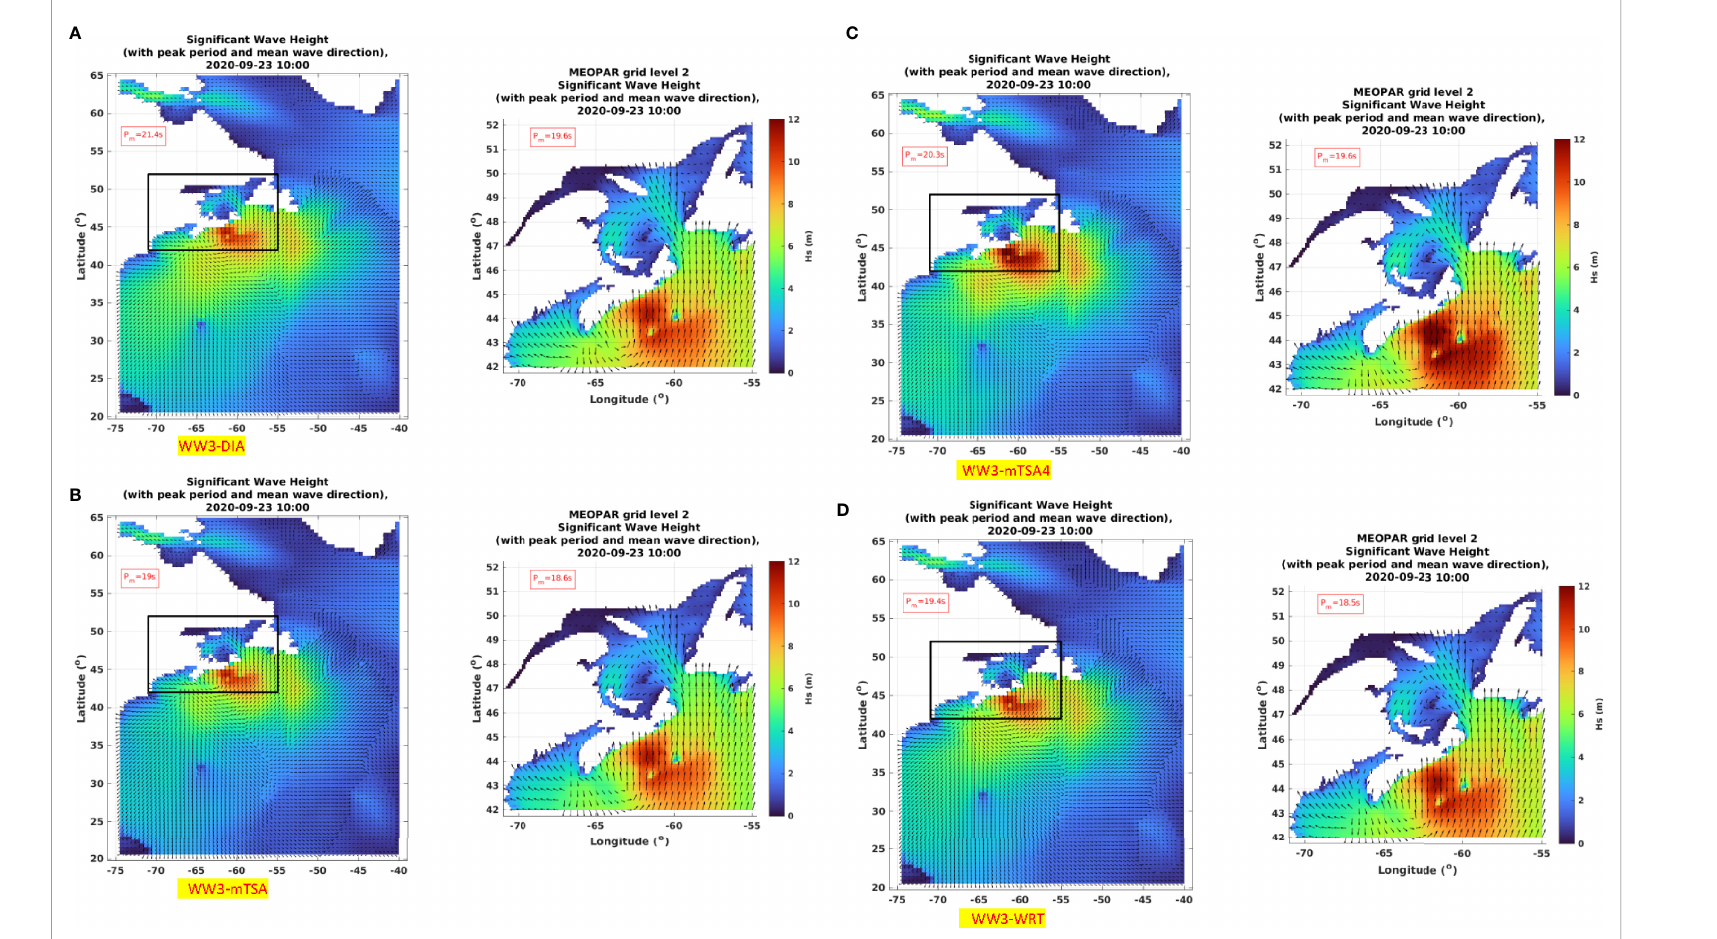
FIGURE 6 | Maps of signi fi cant wave height, at the peak of Hurricane Teddy, showing (A) WW3-DIA, (B) WW3-mTSA, (C) WW3-mTSA4, (D) WW3-WRT. Coarse grid (left panel) is at 0.5° resolution and the nested fi ne-resolution grid (right panel) is 0.1°